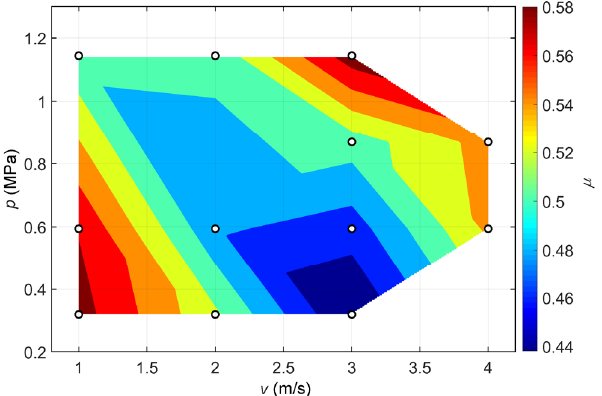
Fig. 2 Nominal contact pressure ( p ) and sliding velocity ( v ) map of the friction coefficient. The p and v used in the pin-on-disc tribometer are marked with circles. The pv -values are represented with dashed